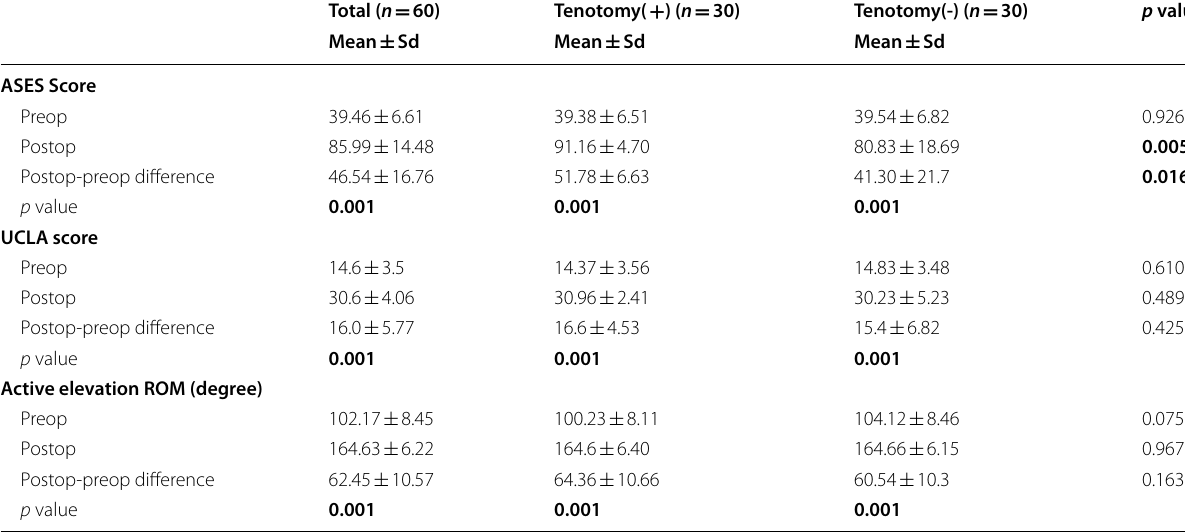
ROM Range of motion, ASES American Shoulder and Elbow Surgeons, UCLA The the University of California-Los